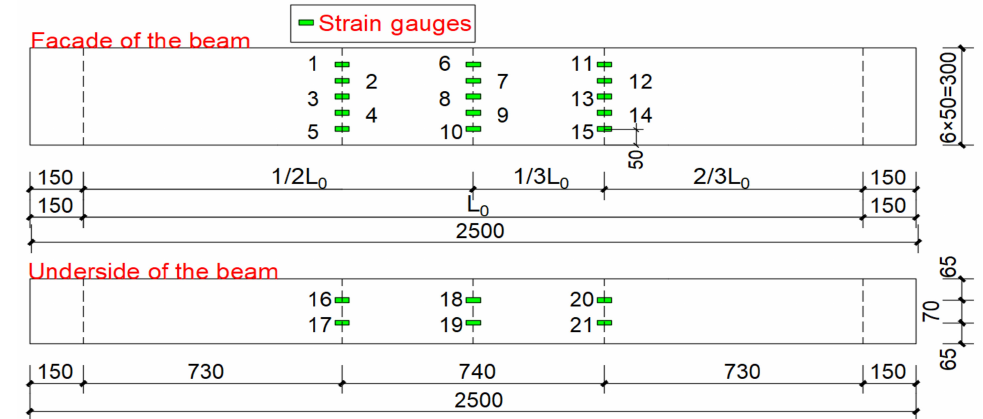
Figure 4. The layout of strain measurement